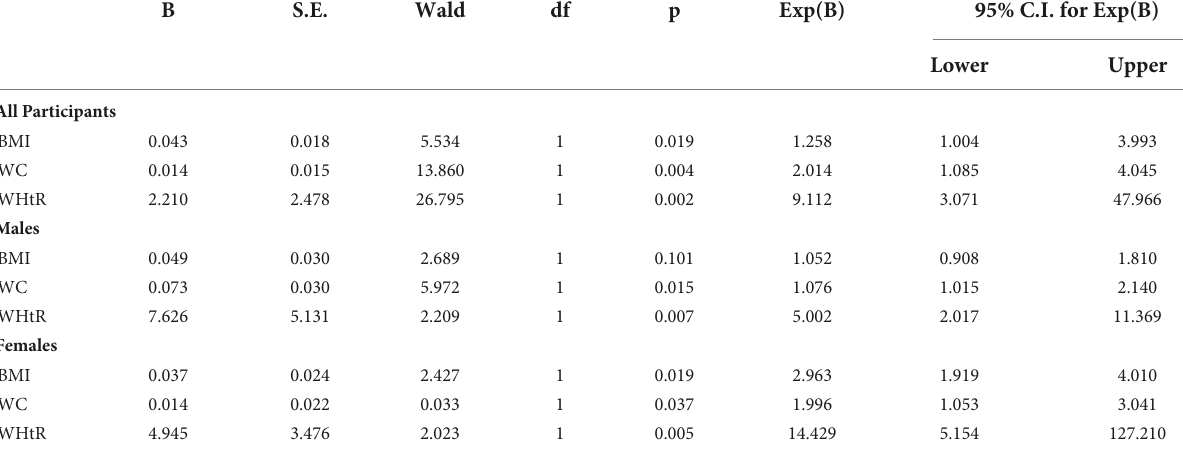
TABLE 2 Logistic regression showing odds ratio of obesity indices for peripheral neuropathy.